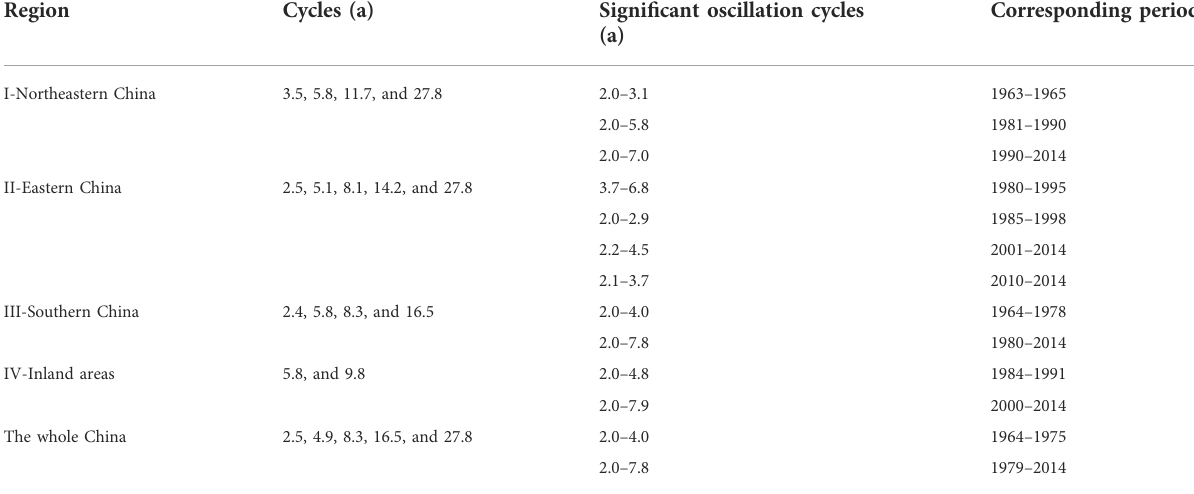
TABLE 2 Oscillation cycles and corresponding periods of TCP in each region.